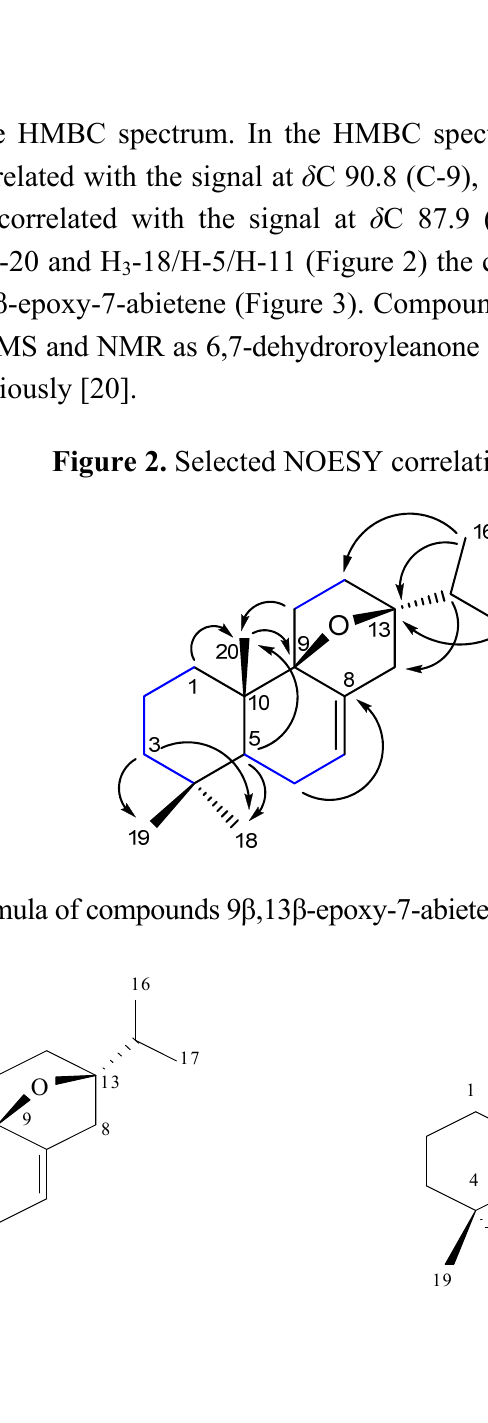
Table 2. Growth inhibition percentage of T. riparia essential oil and isolated